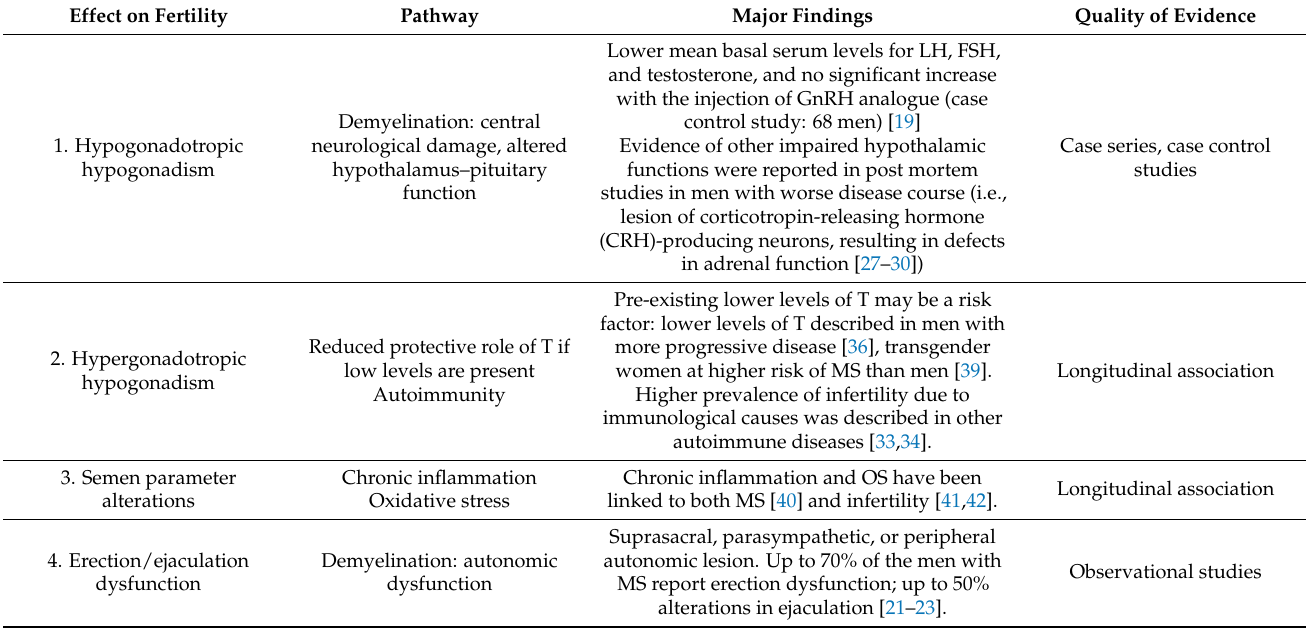
Table 1. Possible rationale for reduced fertility in men with multiple